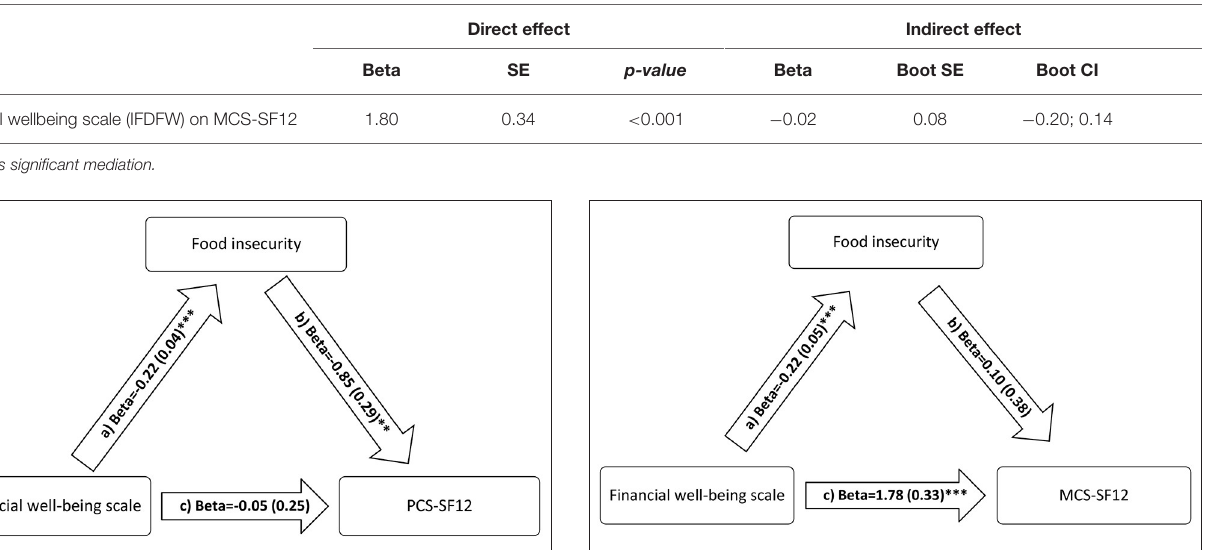
FIGURE 3 | a) Relation between financial wellbeing scale and food insecurity ( R 2 = 19.16%); b) Relation between food insecurity and MCS-SF12 ( R 2